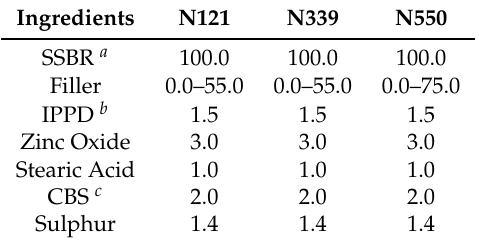
Table 2. Recipe for the reinforcing resin series used in this study (all values in parts per hundred rubber).